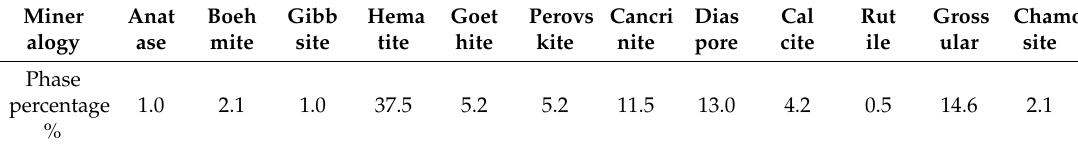
Table 2. XRD Mineralogical Quantification using XDB Software by Sajo